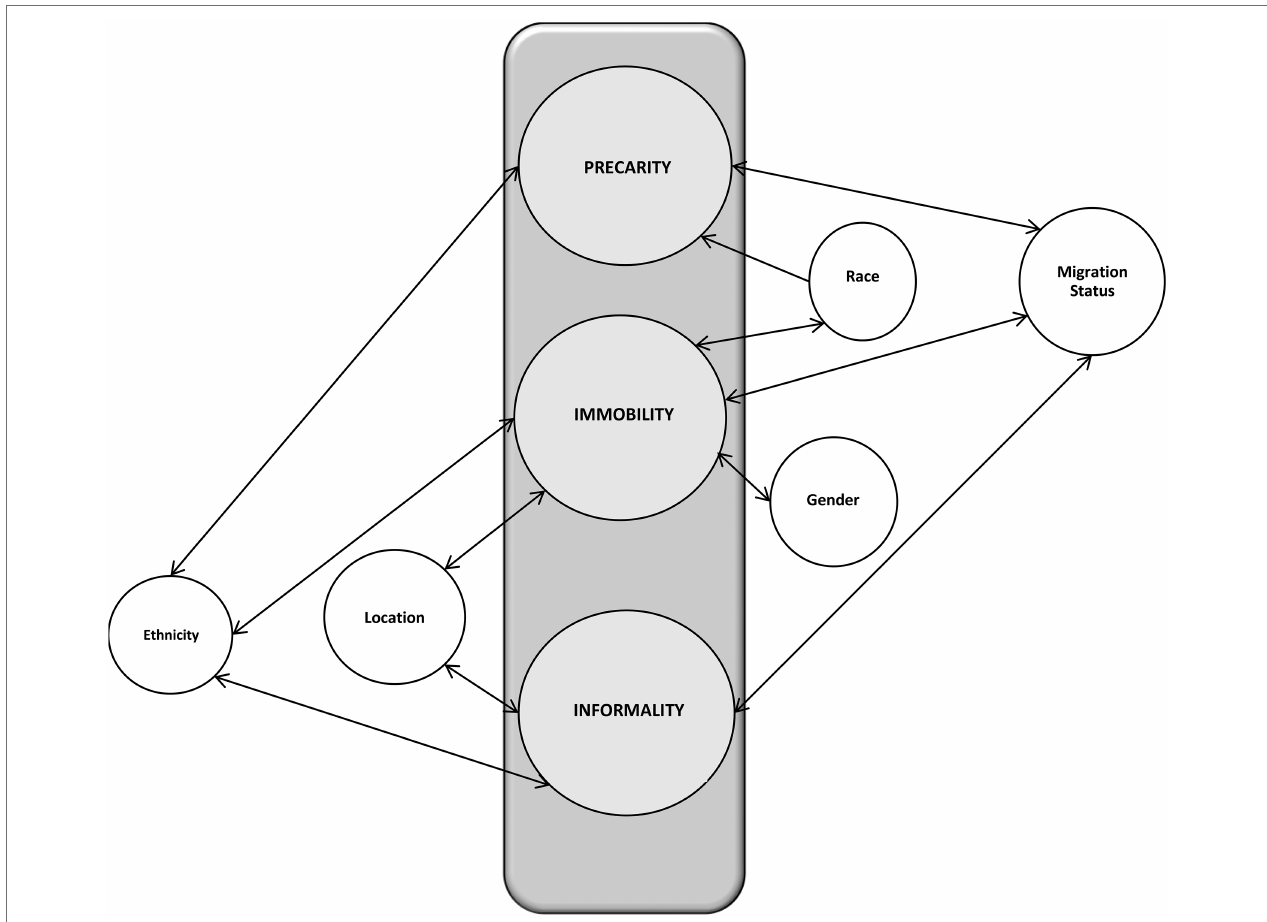
FIGURE 1 | Interrelationship between subjectivities and intersections (author’s own